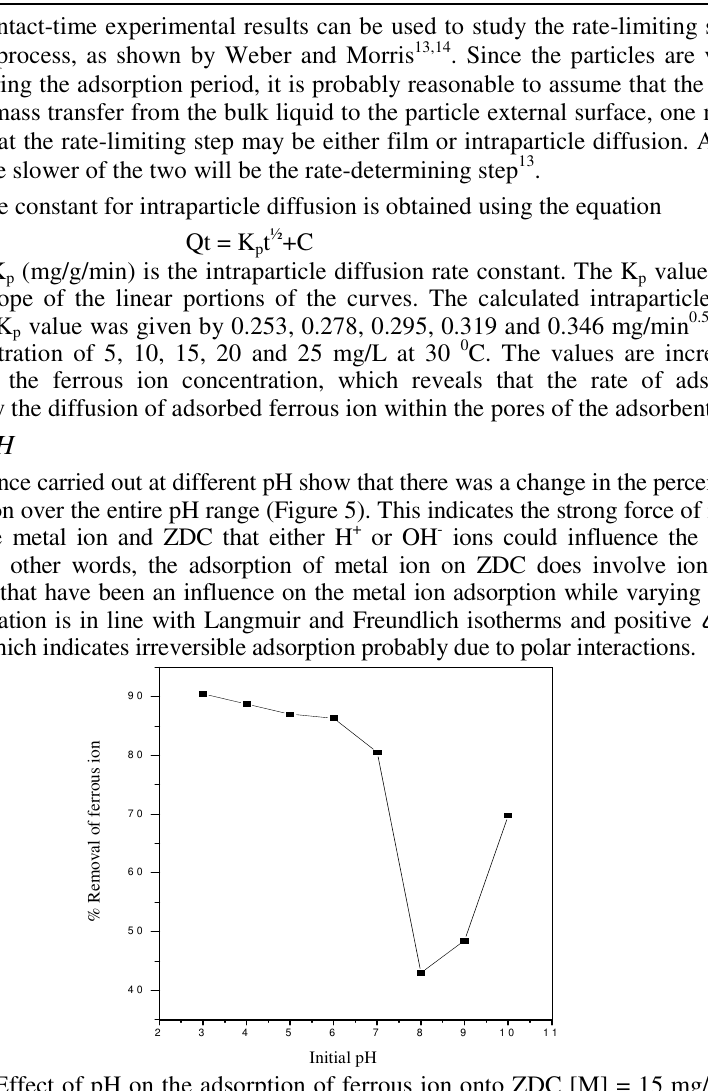
, min -1 ) process 2